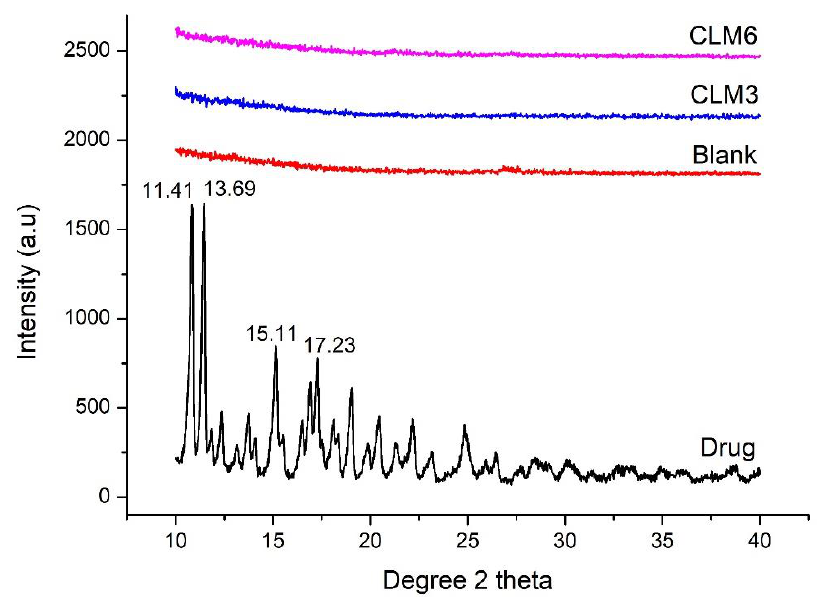
Figure 7. XRD diffraction pattern of CLM3, CLM6, blank microbeads, and clarithromycin.